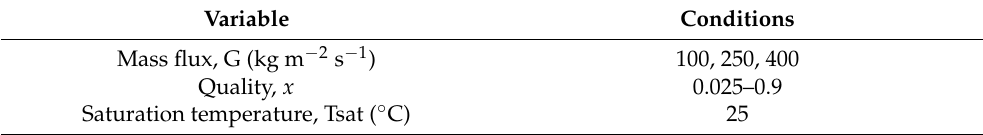
Figure 2. Wojtan– Ursenbacher –Thome flow pattern map for each mass flux (red dot-line) with R32 and T sat = 25 o C; ( a ) 100 kg m − 2 s − 1 ; ( b ) 250 kg m − 2 s − 1 ; ( c ) 400 kg m − 2 s − 1 . Table 2. Summary of experimental conditions. Table 2. Summary of experimental